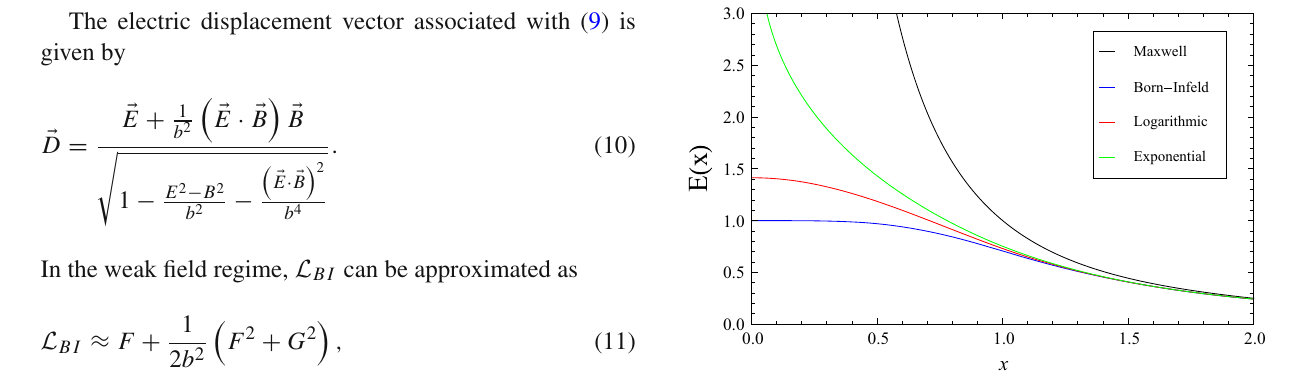
adopting ε = 1 versus a 2 0